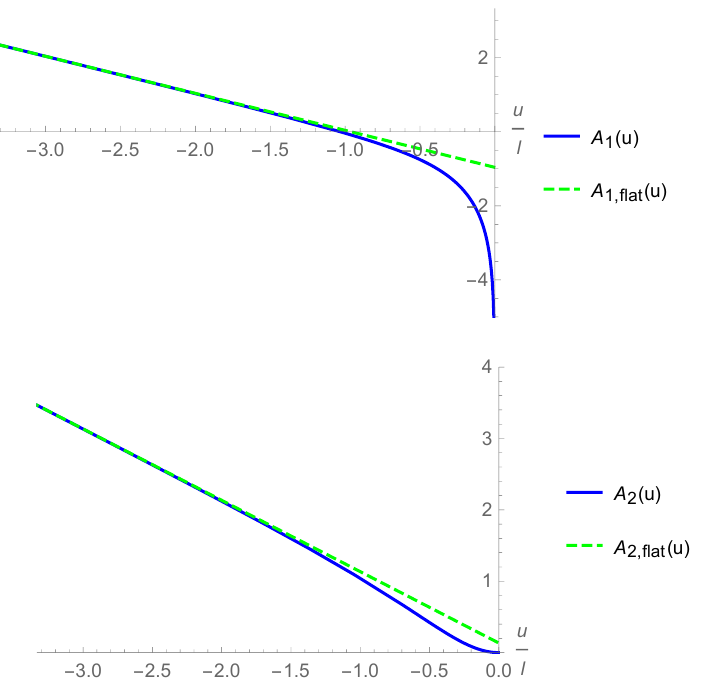
Figure 4 . The blue solid lines show the scale factors A 1 ( u ) (cid:0) A 1 ; 0 (top panel) and A 2 ( u ) (cid:0) A 2 ; 0 (bottom panel) in the case where the sphere 1 shrinks for u 0 =‘ = 0. The constant shifts A 1 ; 0 is given in equation (5.11), whereas A 2 ; 0 , related to T 2 ; 0 in (5.11), (cid:12)xes the initial condition in the IR (see equation (7.2)). It is set so that T 2 ; 0 ‘ 2 = 20. The green dashed line represents the same functions, in the case of a (cid:13)at